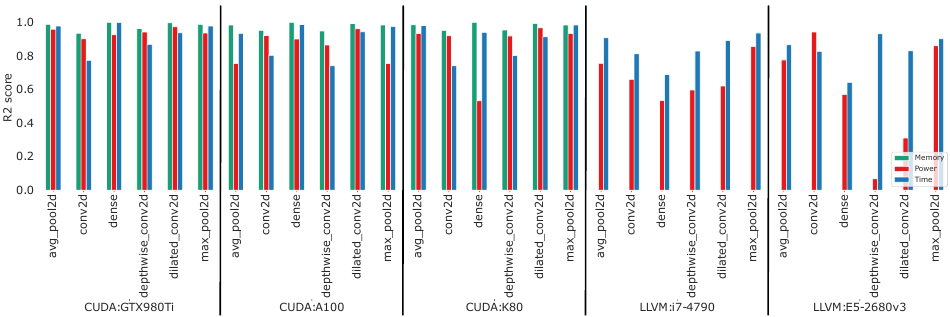
Figure 3. The R2 scores of the best regression models out of the tested methods across all metrics and workload types for the CUDA and x86 targets of the currently collected datasets without the application of any feature